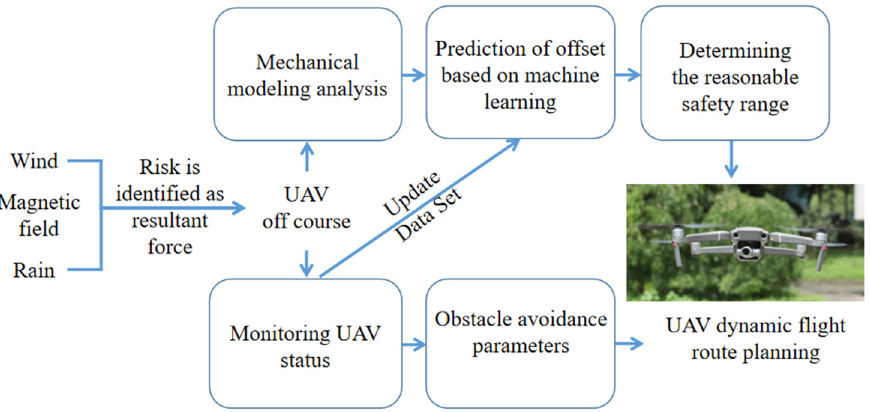
Figure 1. Block diagram of 3D route planning resilience enhancement design.